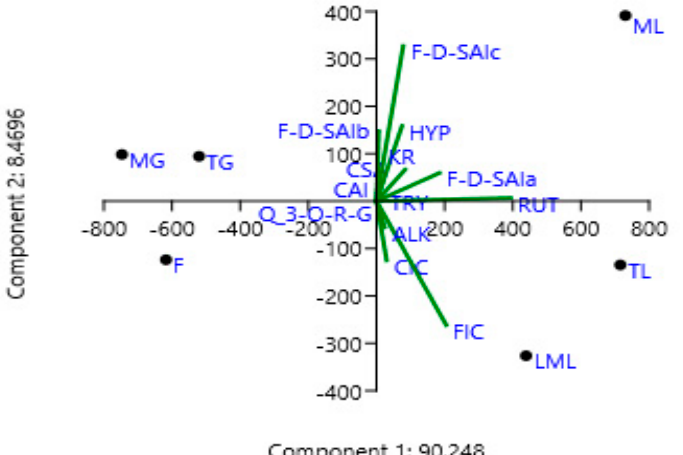
Figure 5. Principal component analysis (PCA) scatter plot of the phenolic compounds in amaranth. CAI, caffeoylsaccharic acid isomer; CSA, coumaoryl saccharic acid; TRY, tryptophan; F- D -SAIa, feruloyl- D -saccharic acid isomer a; F- D -SAIb, feruloyl- D -saccharic acid isomer b; F- D -SAIc, feruloyl- D -saccharic acid isomer c, CIC: Caffeoyl isocitrate, Q 3- O -RG: Quercetin 3- O -rhamnosyl-rhamnosyl-glucoside, FIC: Feruloyl isocitrate, RUT: Rutin, HYP: Hyperoside, KR: Kaempferol rutinoside, ALK: Alkaloid, TL: Tender leaves, ML: Mature leaves, LML: Late maturity leaves, TG: Tender grains, MG: Mature grains, F: Flowers.